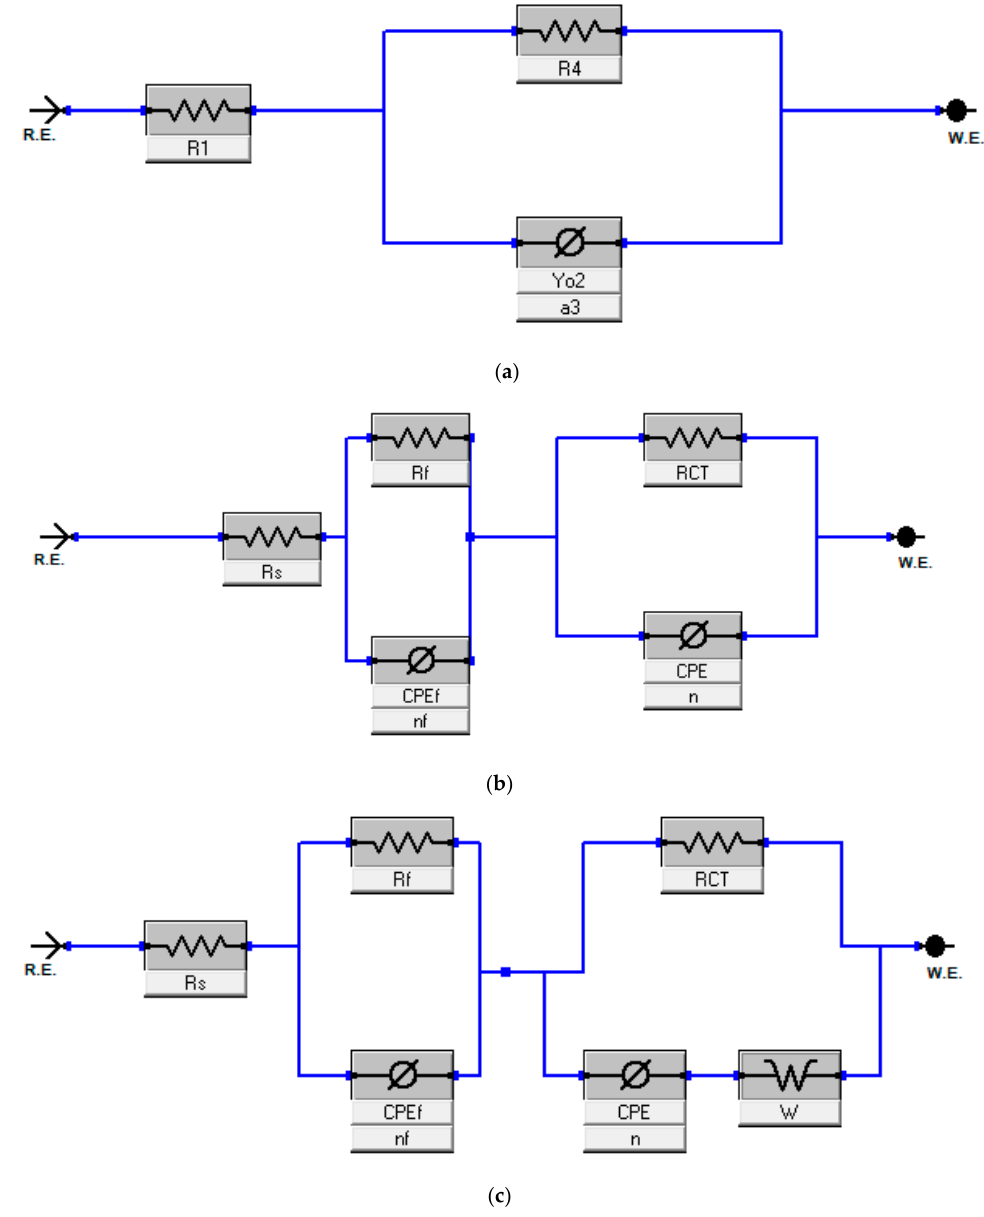
Figure 4. The electrical equivalent circuit (EEC) used to fit the impedance plots data ( a – c ) for models A, B and C respectively. ( a ) Model A. ( b ) Model B. ( c ) Model C.